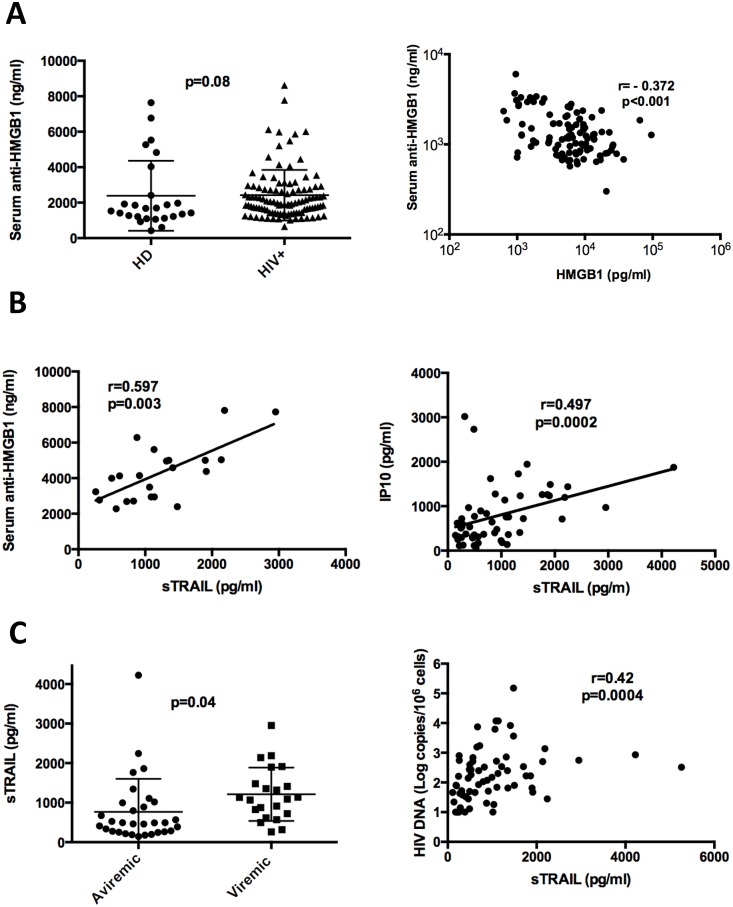
Circulating levels of HMGB1-specific antibodies, sTRAIL, and IP-10 in HIV-1 infected patients.(A): Serum from healthy donors (n = 12) and HIV-1-infected patients (n = 67) were tested for their content in total (residual + HMGB1-bound) HMGB1-specific IgG antibodies with an in-house ELISA assay, as described in M&M. Median and IQR are shown on the left hand side diagram. Spearman correlation between residual HMGB1 and total anti-HMGB1 antibodies is shown on the right hand side. (B): Spearman correlation between sTRAIL and total anti-HMGB1 antibodies in viremic patients (n = 22) on the left hand side, and between sTRAIL and IP-10 (n = 67) on the right hand side. (C): Comparative levels of circulating sTRAIL in aviremic (n = 19) vs viremic (n = 22) HIV-infected patients on the left hand side; spearman correlation between sTRAIL and HIV proviral DNA in the whole group HIV-infected patients (n = 67).